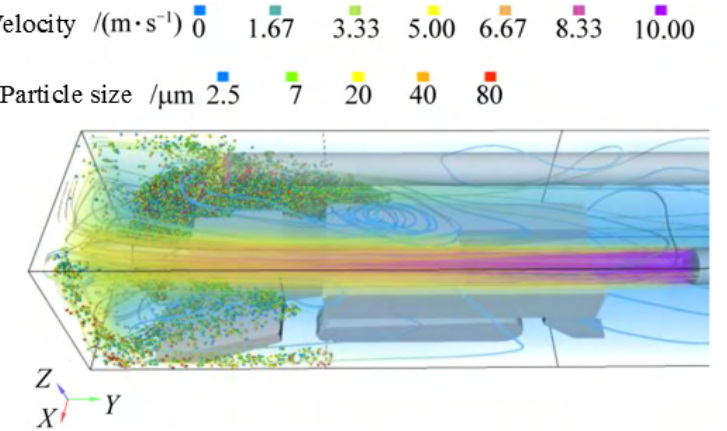
Figure 4. Migration law of wind dust coupling field during long pressure and short exhaust [50].